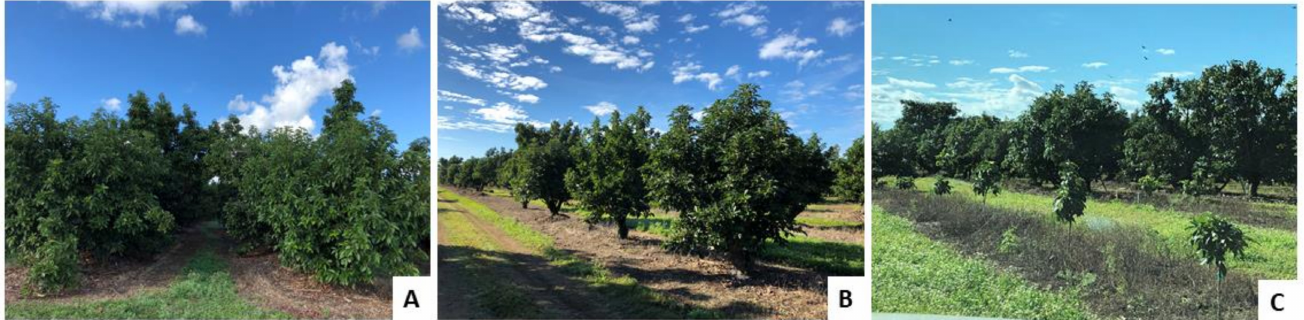
Figure 1. Commercial avocado orchards exhibiting three canopy covers. ( A ) Full canopy, ( B ) Top- worked, ( C ) New planting. Photo credit: J. H.